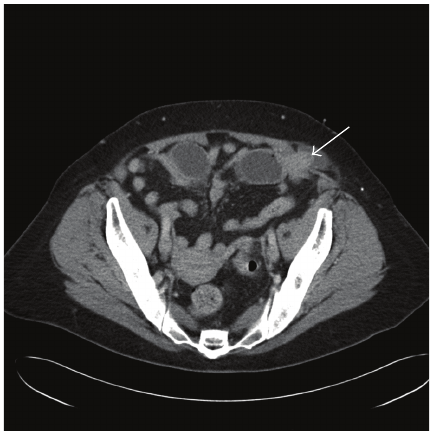
Figure 1: Computed tomography (CT) of the abdomen demon- strating a left-sided spigelian hernia with incarcerated loop of small bowel (white arrow points to loop of small bowel